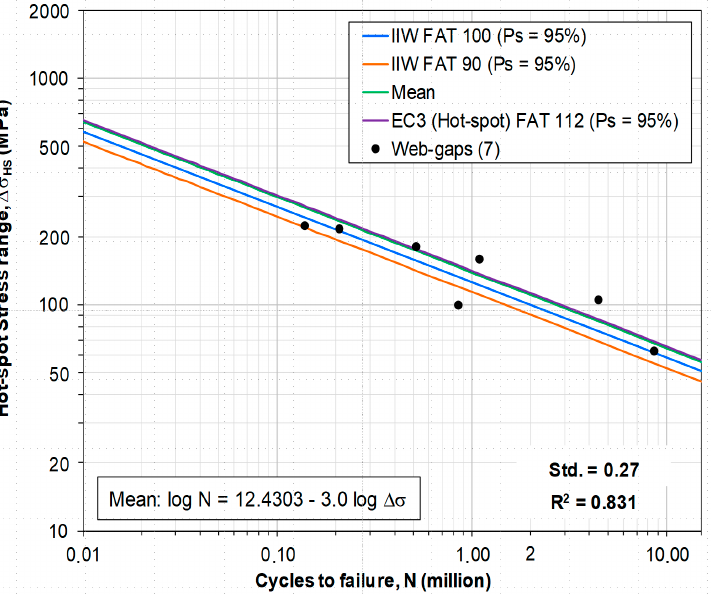
Figure 15. Structural hot-spot stress results for welded bridge details (refer to Figure